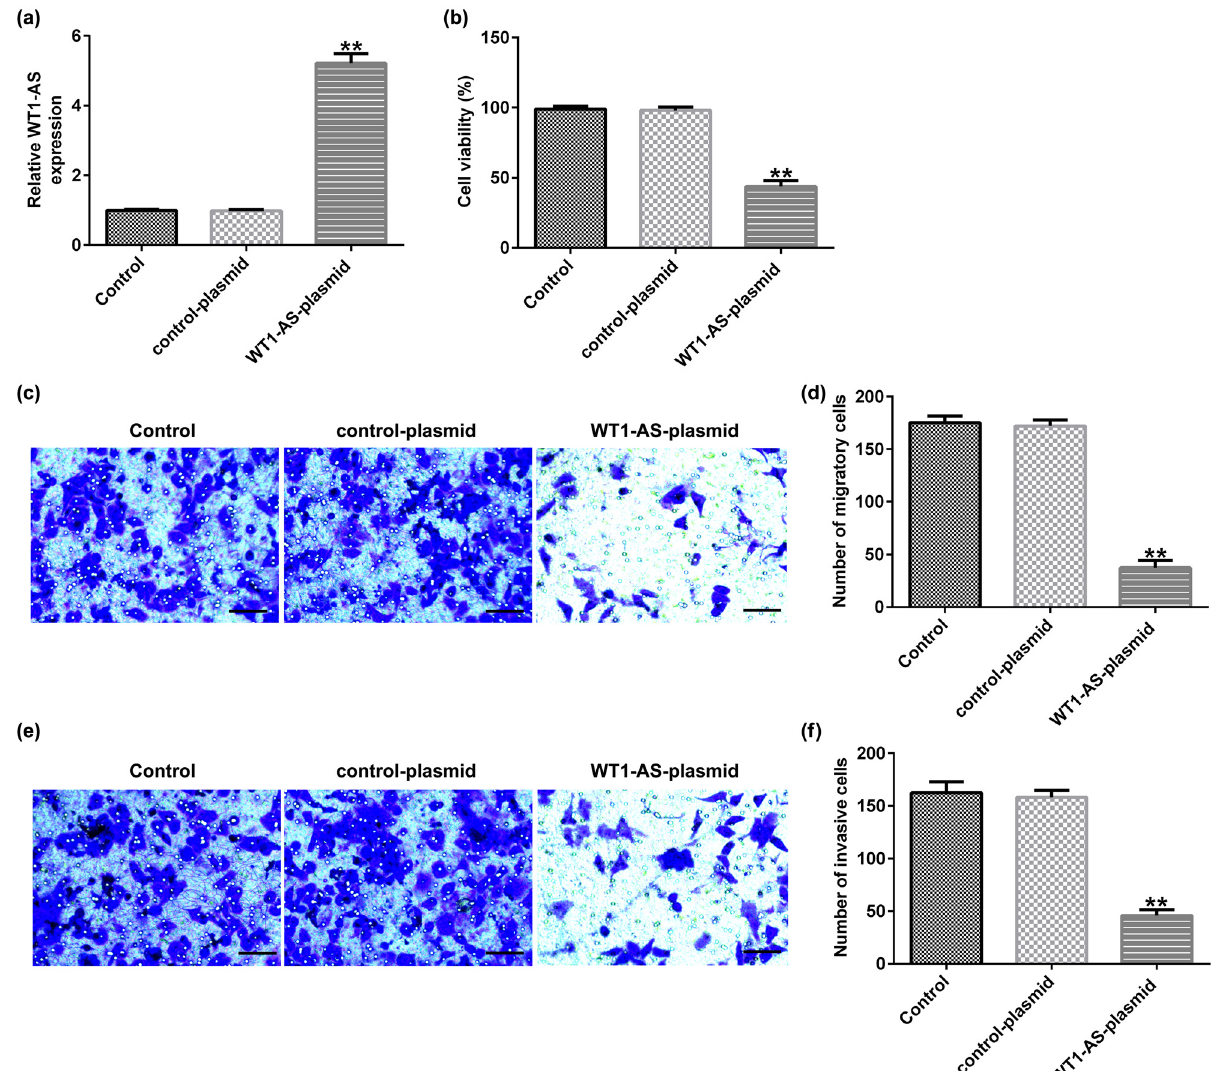
Figure 1: E ff ects of WT1 - AS - plasmid on HTR - 8/SVneo cell viability, migration, and invasion. ( a ) qRT - PCR analysis was used to determine the transfection e ffi ciency of control plasmid and WT1 - AS plasmid in HTR - 8/SVneo cells. ( b ) The viability of HTR - 8/SVneo cells was determined using the MTT assay. HTR - 8/SVneo cell migration ( c ) and invasion ( e ) ( magni fi cation: × 100; bar = 100 μ m ) were assessed by Transwell assay. The number of migratory cells ( d ) and invasive cells ( f ) were determined. ** P < 0.01 vs control plasmid. WT1 - AS, WT1 antisense